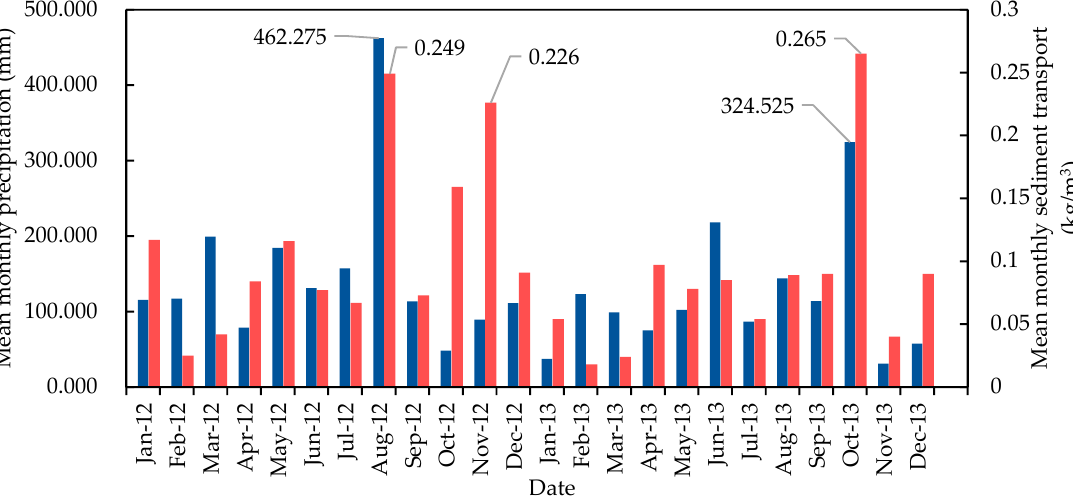
Figure 13. Mean monthly precipitation and mean monthly sediment discharge in the West Tiaoxi River Basin from 2012 to 2013.